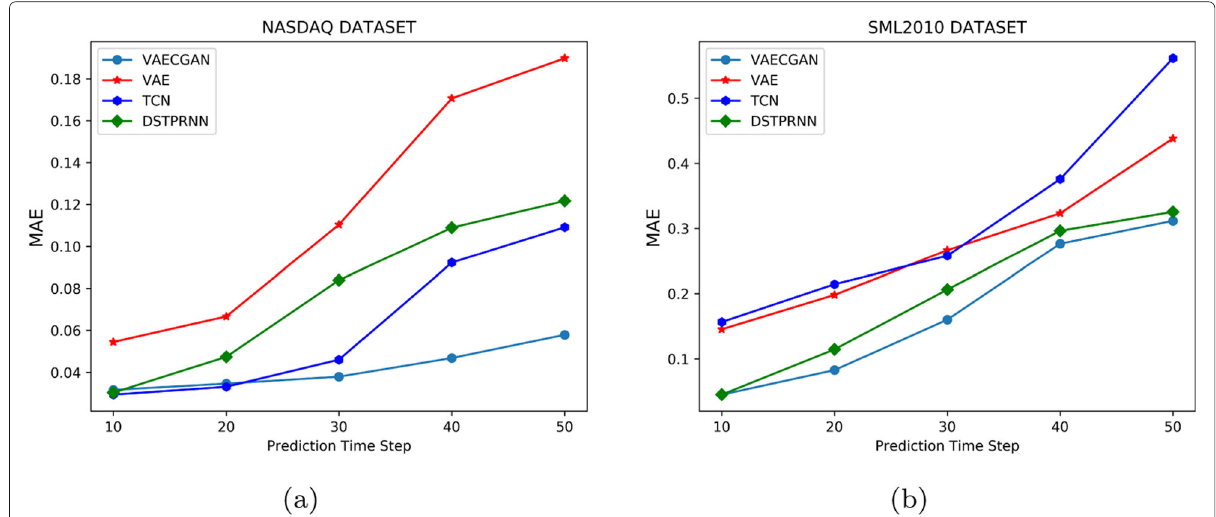
Fig. 4 MAE vs. Length of Prediction Timesteps( (cid:2) ) over NASDAQ (a) and SML(b)